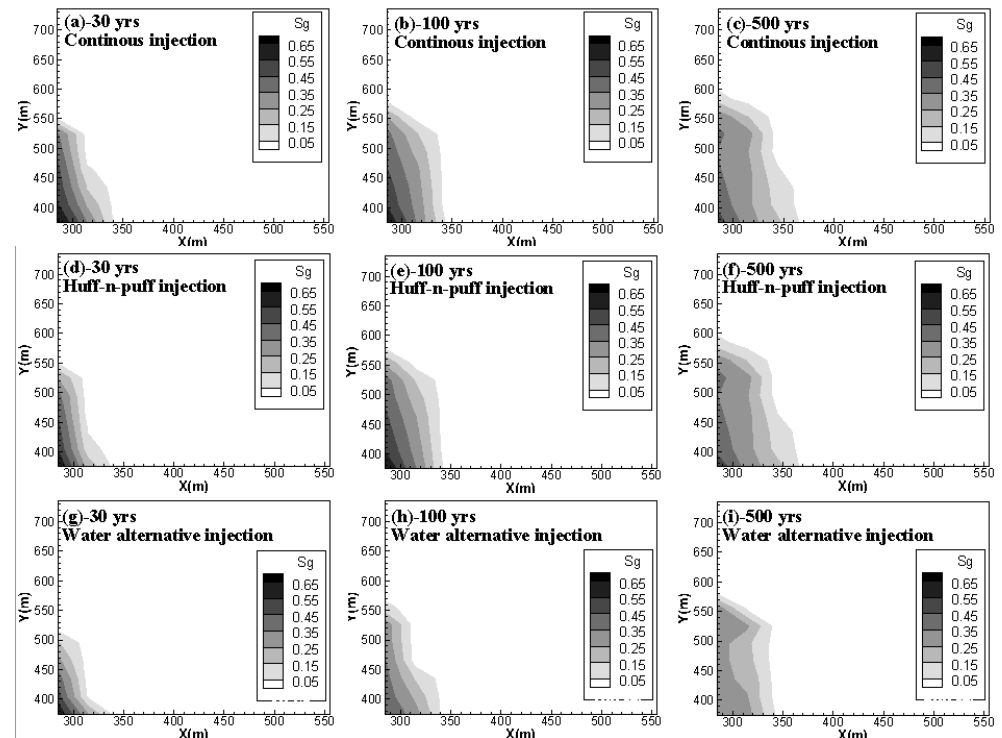
Figure 8. Free CO 2 distributions for case 2, case 4 and case 5 at 30, 100 and 500 years. ( a , b , c) compares the gas phase CO 2 distribution of continuous injection scenario at 30 yrs, 100 yrs and 500 yrs, respectively; ( d , e , f) shows the gas phase CO 2 distribution of huff-n-puff injection scenario at 30 yrs, 100 yrs and 500 yrs; ( g , h , i) gives gas phase CO 2 distribution of water alternative injection scenario at 30 yrs, 100 yrs and 500 yrs.